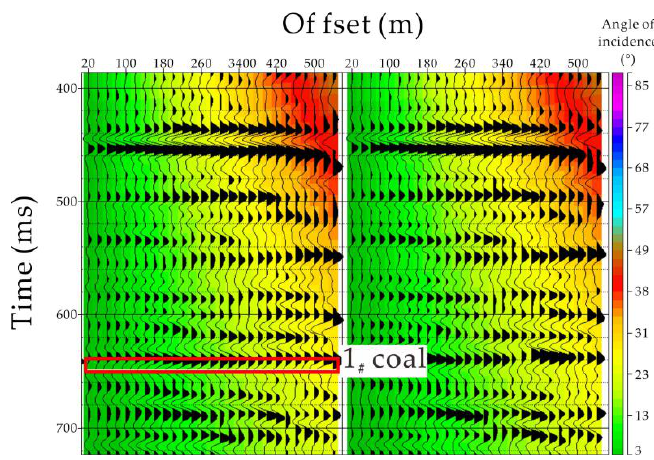
Figure 2. The 3D CRP seismic data profile in the study area .